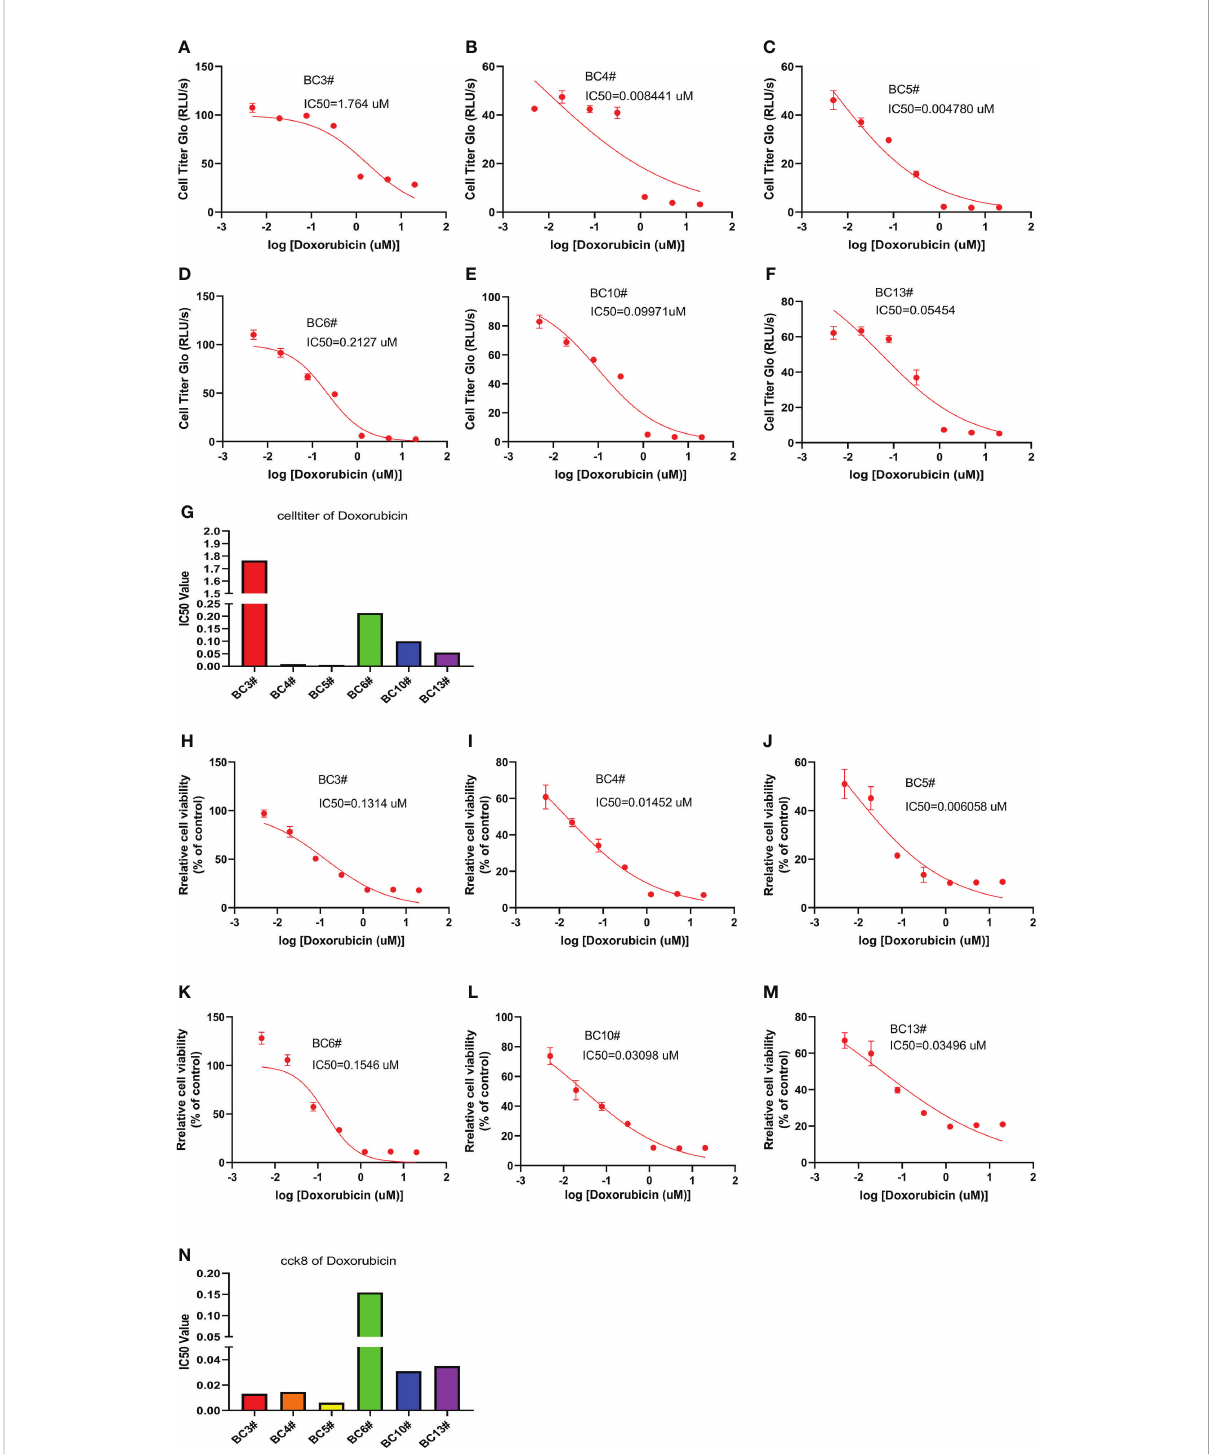
FIGURE 4 The killing assay of doxorubicin by the CellTiter-Glo and CCK8 assays. (A – G) The CellTiter-Glo assay to measure the IC 50 value of doxorubicin in the primary breast cancer cells BC3, BC4, BC5, BC6, BC10, and BC13. (H – N) The CCK8 assay to measure the IC 50 value of doxorubicin in the primary breast cancer cells BC3, BC4, BC5, BC6, BC10, and